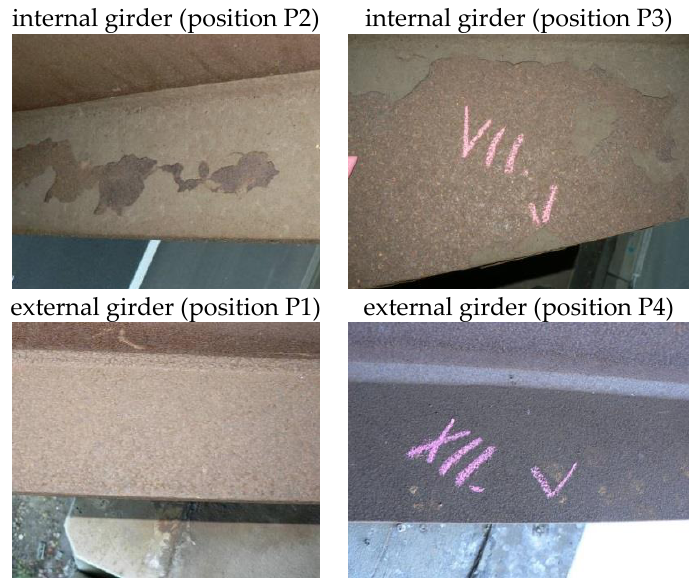
Figure 5. Development of corrosion products on the bottom flanges of the main girders on bridge B1: above — detrimental development on inner surfaces; below — acceptable development on outer surfaces.